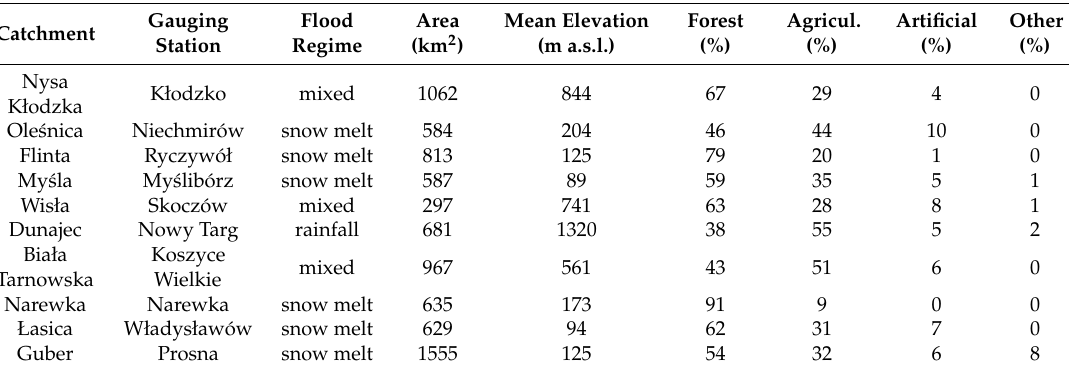
Table 1. List of catchments and their characteristics.